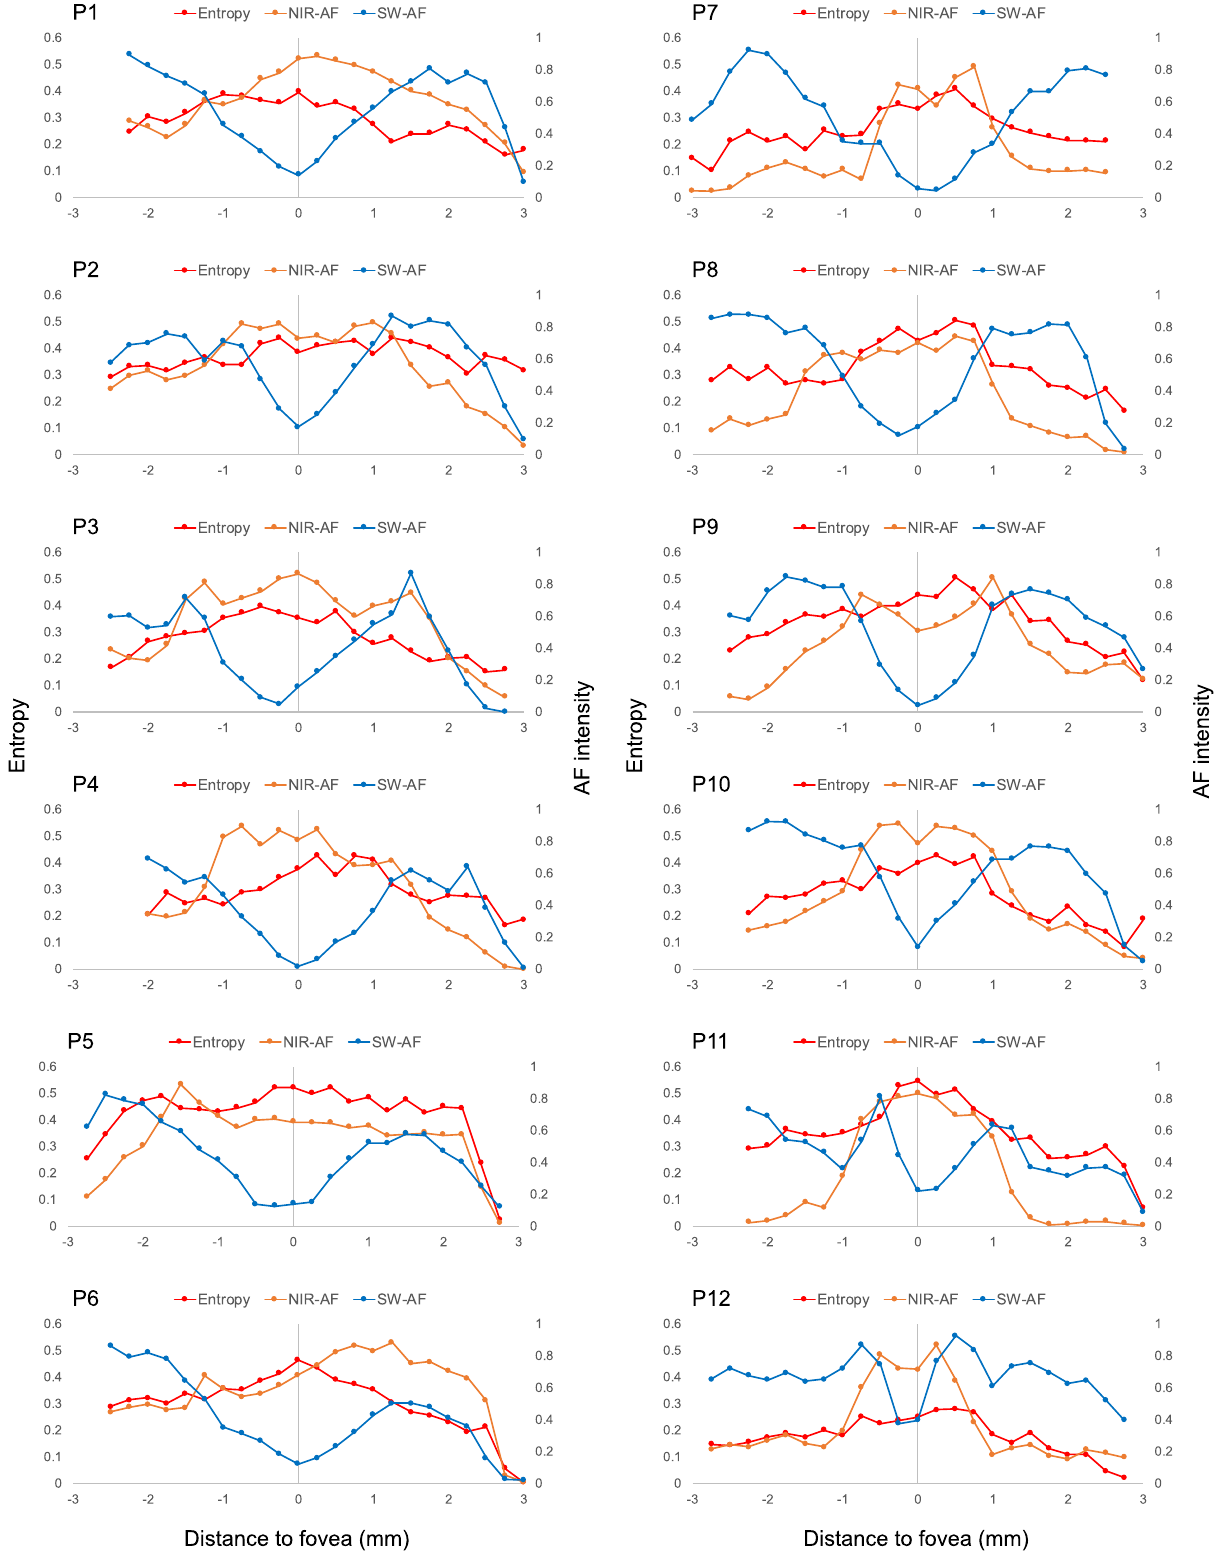
Figure 2. Distribution of entropy values, near-infrared and short-wavelength autofluorescence intensities for each